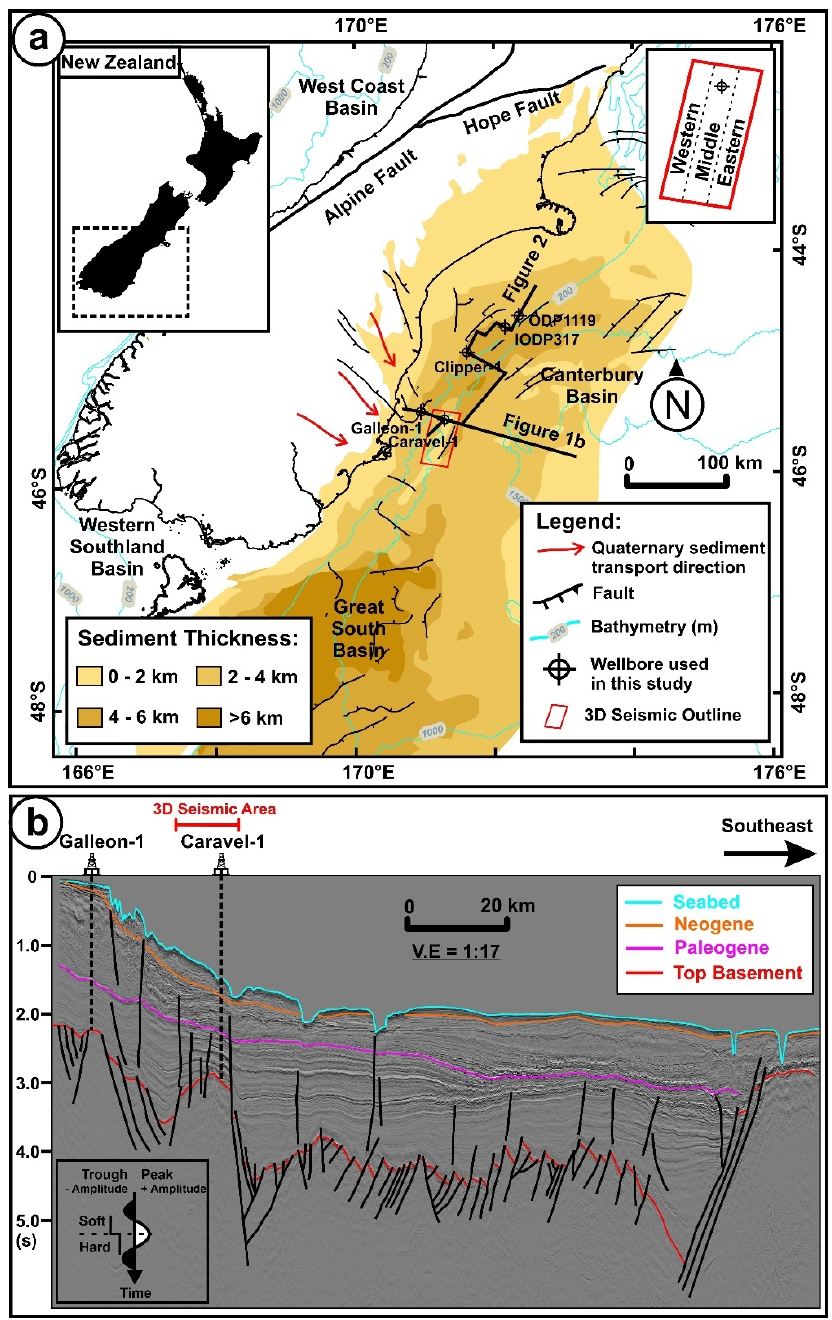
Figure 1. ( a ) Map of the study area with sediment thickness information from O’Leary and Mogg [38]. The red rectangle on the inset map is the western-middle-eastern zonation in the study area. ( b ) Regional NW-SE seismic and geological cross-section through the study area. See Figure 1a for section location.